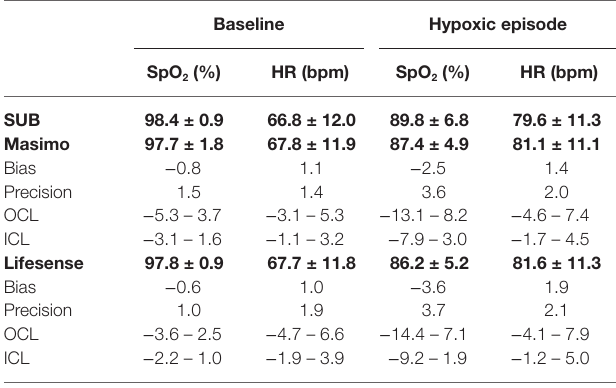
(ICL) are shown for Masimo vs. SUB and Lifesense vs. SUB,